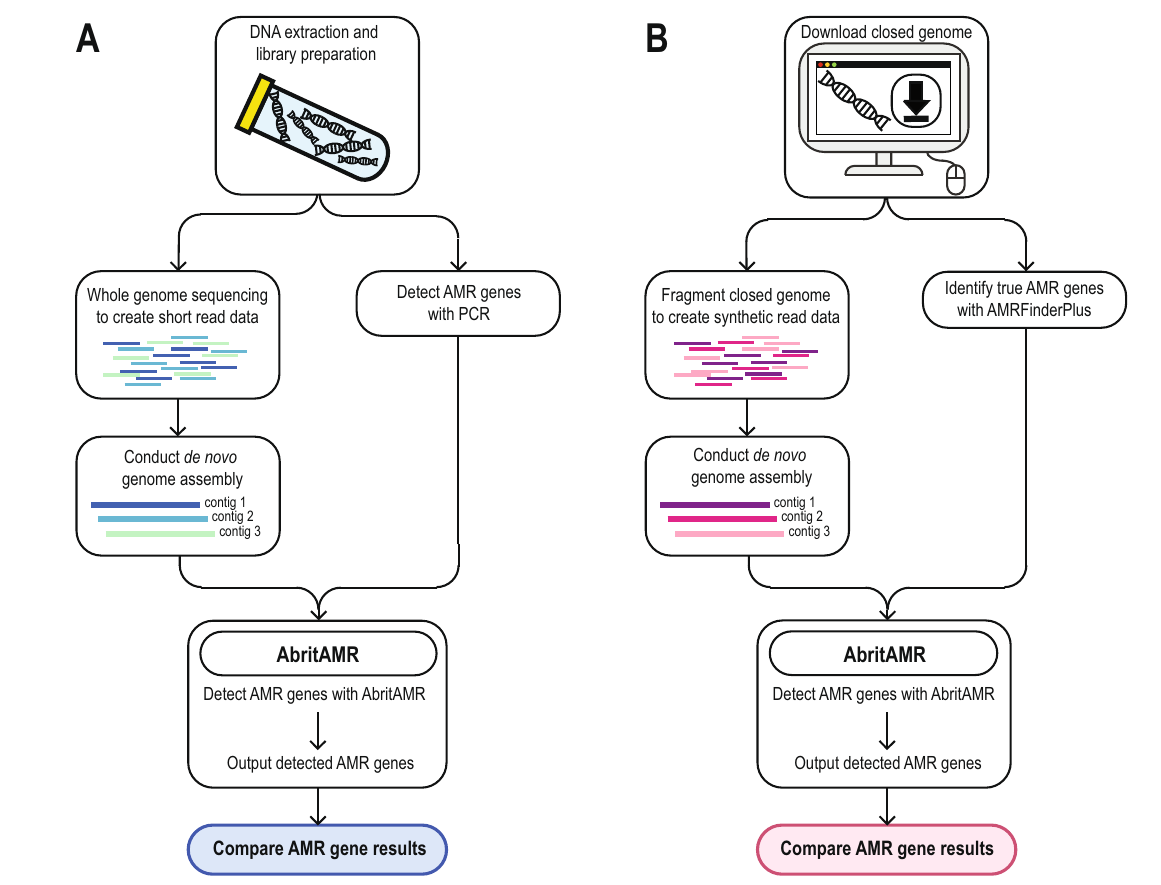
Fig. 3 | Validation of abritAMR outputs compared to PCR and synthetic read data. A Validation compared to PCR data – Assembled short-read sequence data from bacterial isolates are run through the abritAMR pipeline and compared to multiplex real-time PCR results for the same AMR genes. B Synthetic data – where no validation dataset or PCR assay was available for comparison, synthetic read data were generated from publicly-available closed reference genomes by